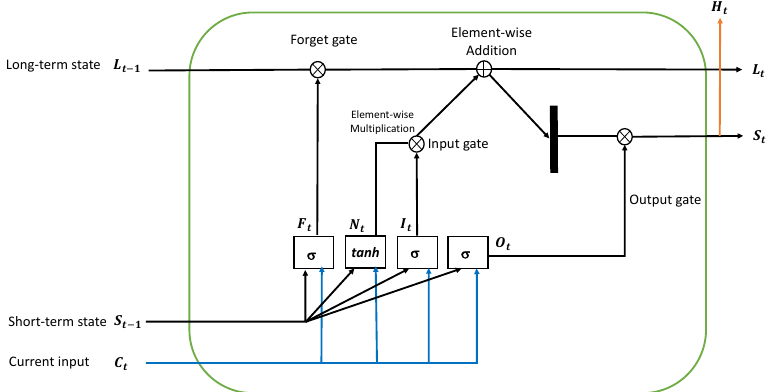
Figure 11. Long short-term memory